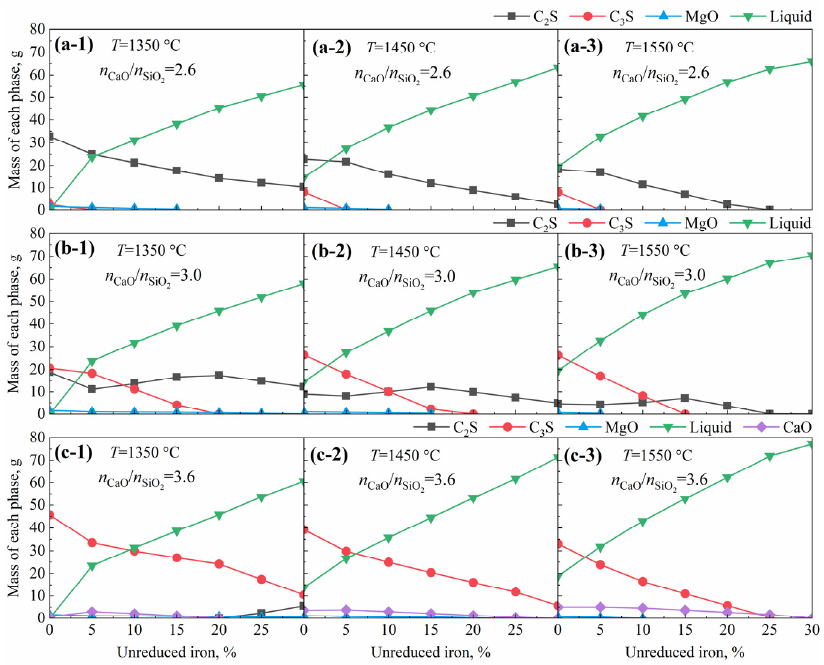
Figure 13. The effect of unreduced iron on gelling components: ( a ) = 3.0; ( c ) n = 3.6; ( 1 ) T = 1350 ◦ C; ( 2 ) T = 1450 ◦ C; ( 3 ) T = 1550 ◦ n CaO / n SiO CaO / n SiO 2 2